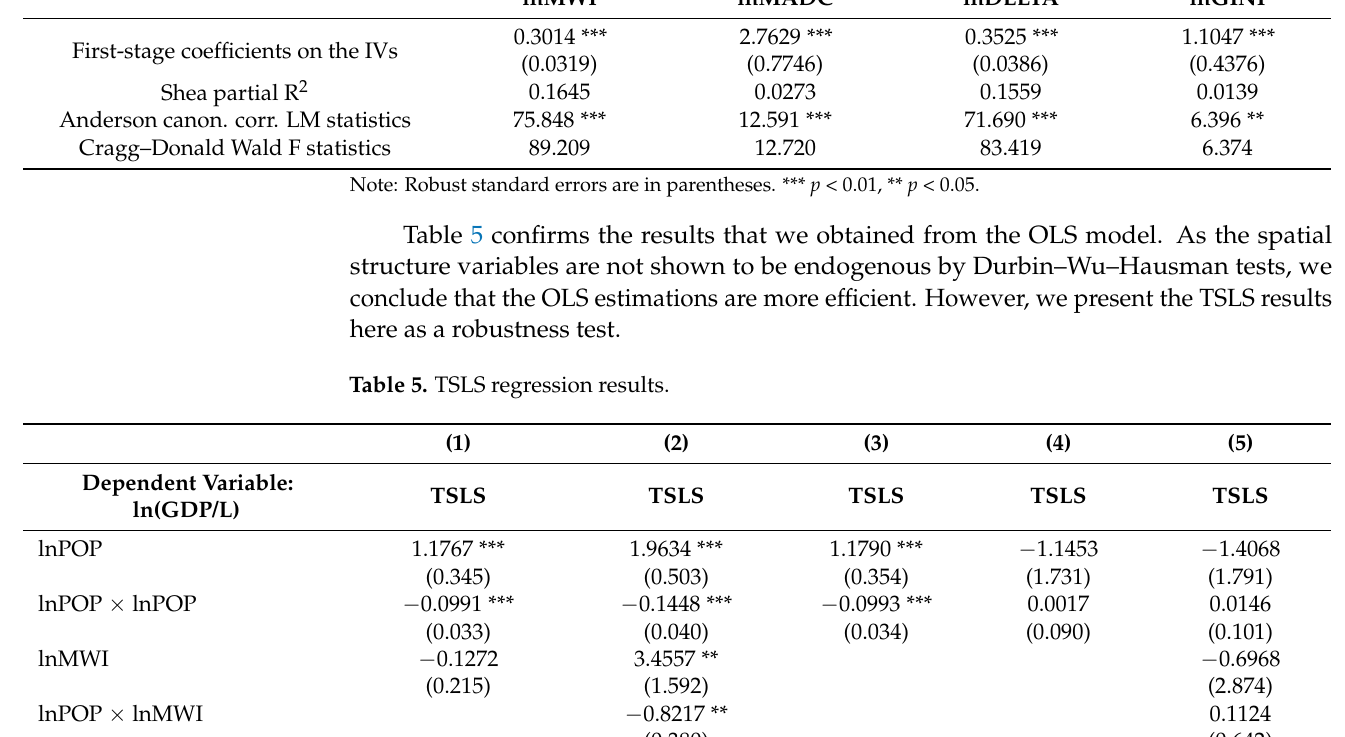
Table 4. The first stage of the IV regressions. lnMWI lnMADC lnDELTA lnGINI